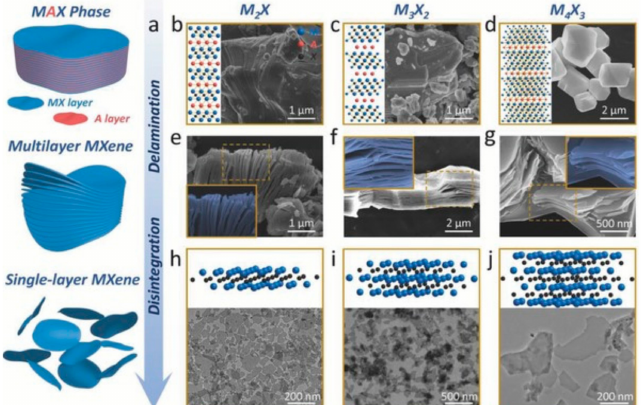
Figure 1. Methods for synthesis of MXenes for biomedical applications. ( a ) Synthesis of MXenes by delamination, disintegration, and, finally, by surface modification. ( b ) A 2D MAX phase model with corresponding scanning electron microscopy (SEM) image for M 2 X, ( c ) 2D model and corresponding SEM image of MAX phase for M 3 X 2 , ( d ) 2D model and corresponding SEM image for M 4 X 3 MAX phase, ( e ) SEM image of M 2 X, ( f ) SEM image of M 3 X 2 , ( g ) SEM image of M 4 X 3 , and ( h ) 3D model with corresponding transmission electron microscopy (TEM) image for M 2 X-based MXenes, ( i ) 3D model and corresponding TEM image for M 3 X 2 -based MXenes, and ( j ) 3D model and corresponding TEM image for M 4 X 3 -based MXenes. Reprinted from ref. [15], Copyright (2020), with permission from